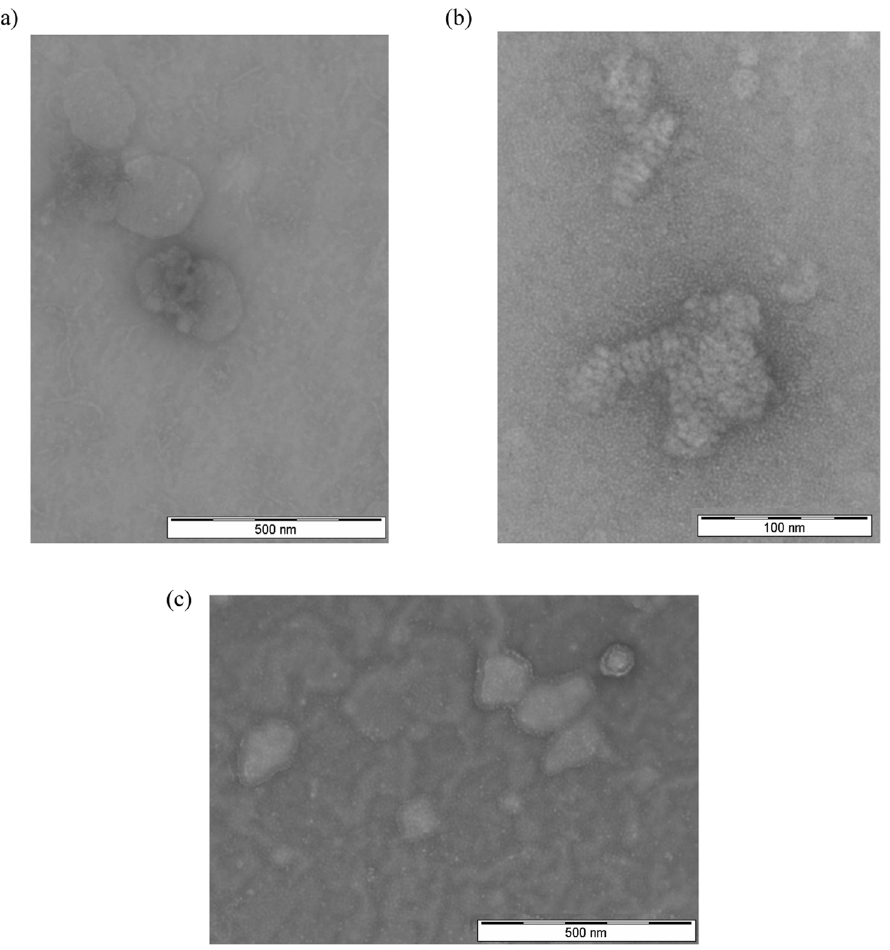
Figure 2. Morphology of CD.siRNA complexes assessed by transmission electron microscopy. (a) Cationic CD alone with no siRNA (magnification: x 60,000) (b) Cationic CD: PEGylated CD Molar ratio 1:0 (i.e. no PEG) (magnification: x 250,000) and (c) Cationic CD: PEGylated CD Molar ratio 1:1 (magnification: x 60,000). (Negative staining with 2% uranyl acetate).